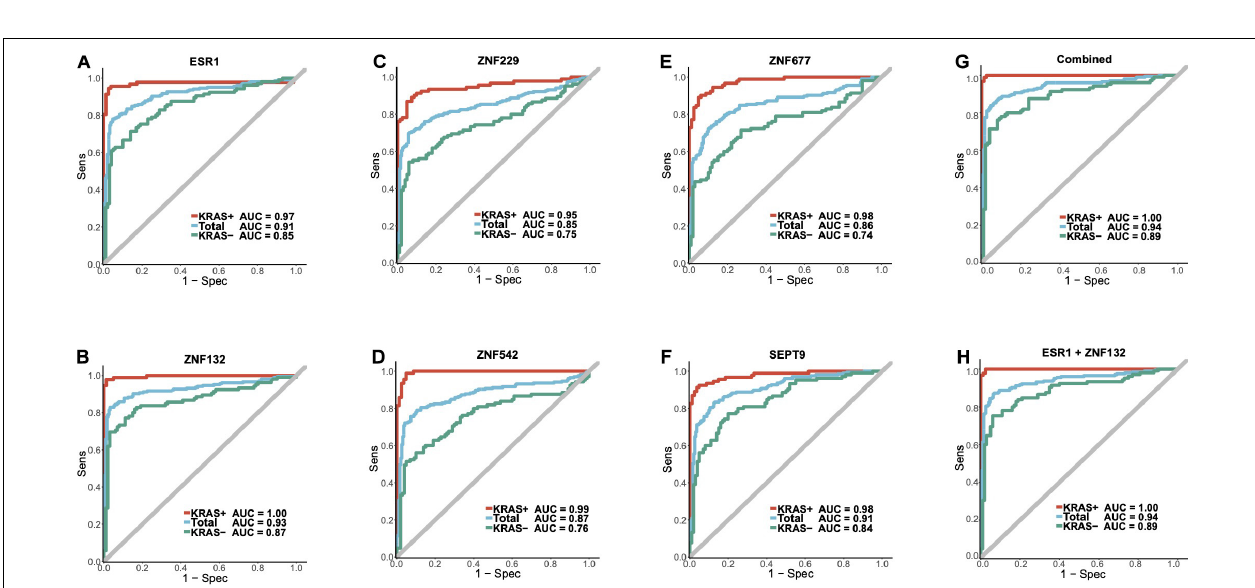
Frontiers in Cell and Developmental Biology |